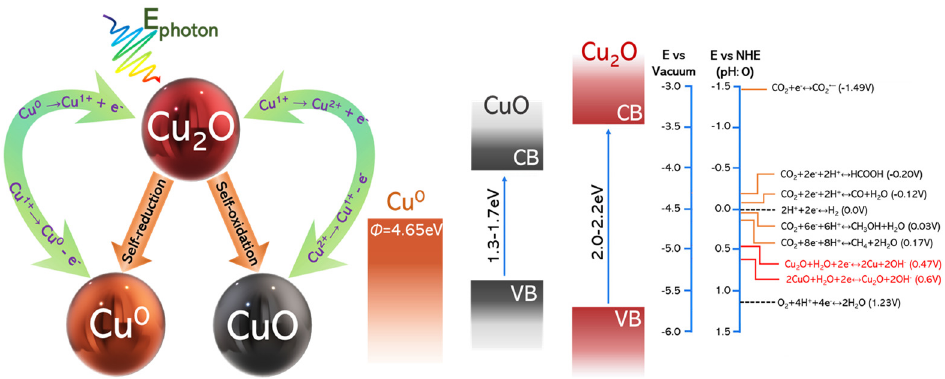
Figure 2. The photocorrosion pathways can involve either “self − oxidation” or “self − reduction” of Cu 2 O. This is related to the positions of the redox couples Cu 1+ /Cu 2+ and Cu 1+ /Cu 0 relative to the E VBand and E CBand